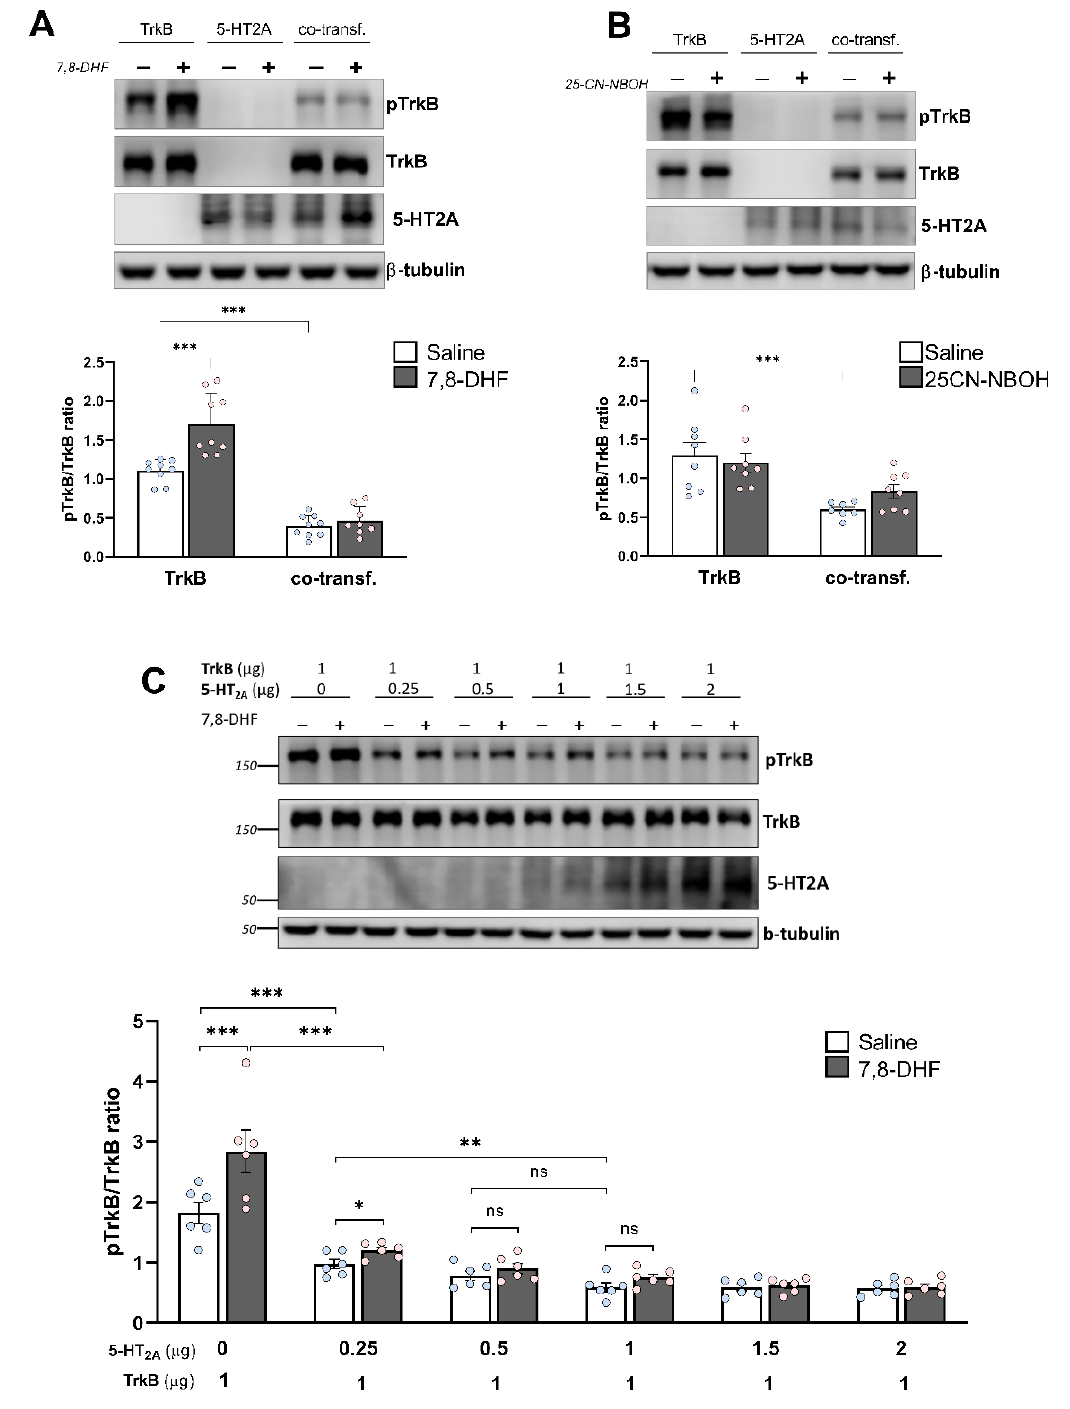
Figure 4. Heterodimerization affects TrkB phosphorylation. ( A , B ) Analysis of TrkB phosphorylation. Neuroblastoma N1E-115 cells expressing either HA-tagged 5-HT 2A (1 μg), GFP-tagged TrkB (1 μg), or co-expressing equal amounts of both receptors were treated for 30 min with either ( A ) the 5-HT 2A receptor agonist 25CN-NBOH (1 μM) or ( B ) the TrkB agonist 7,8-DHF (500 nM). Cells were lysed, followed by SDS-PAGE and Western blot (WB) analysis using antibodies against either total TrkB or phosphorylated TrkB. The 5-HT 2A receptor was detected in parallel. In WB, ß-tubulin was used as a loading control. Representative Western blots are shown. Lower panels show the quantification of TrkB phosphorylation, which was performed by densitometry and calculated as the ratio of total TrkB expression to the TrkB phosphorylation signal after adjustment for the general expres- sion level. Bars show means ± SEM ( n ≤ 8). *** p < 0.001 (two-way ANOVA). ( C ) Heterodimerization affects agonist-mediated TrkB phosphorylation. Neuroblastoma cells were co-transfected with 1 μg of cDNA encoding the GFP-tagged TrkB receptor, together with increasing concentrations of HA- tagged 5-HT 2A receptor. Cells were treated for 30 min with either 500 nM 7,8-DHF or vehicle, fol- lowed by WB analysis. Lower panel: Quantification of TrkB phosphorylation. Bars show means ± SEM ( n = 6). ns: not significant, * p < 0.05, ** p < 0.01, *** p < 0.001 (two-way ANOVA).